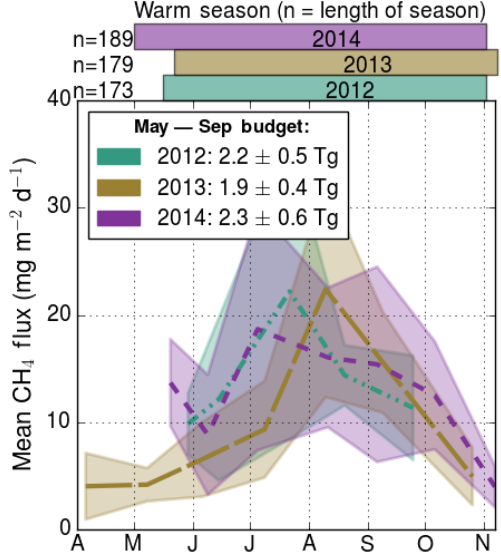
Figure 4. Monthly-mean CH 4 flux estimates. Values are centered on the mean measurement date for a given month, and the shaded regions are the standard deviations of the individual flux estimates weighted by the 95% CI for each estimate. See text for additional details. The bar plot above the graph marks the days when aver- age soil temperatures from NARR were above zero, with the total number of unthawed days given by n